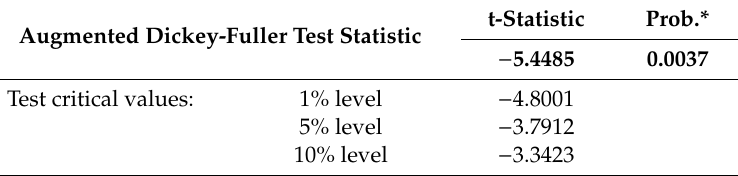
Table 11. Square root test of first order di ff erential of NMGM residual.